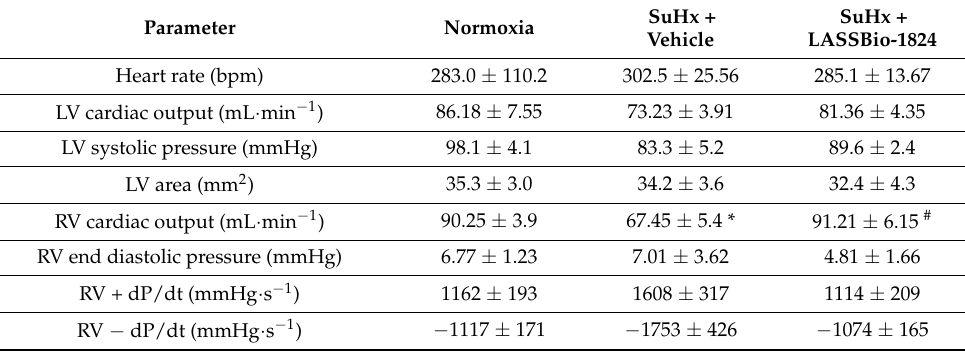
Table 3. Cardiac function and ventricular hemodynamic